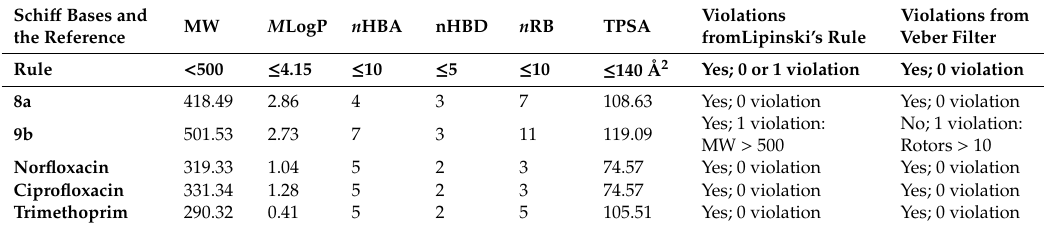
Table 10. In silico the physicochemical properties of the two pyrazole Schi ff bases ( 8a and 9b ) and the reference drugs for Lipinski’s rule of five and Veber filter:-.